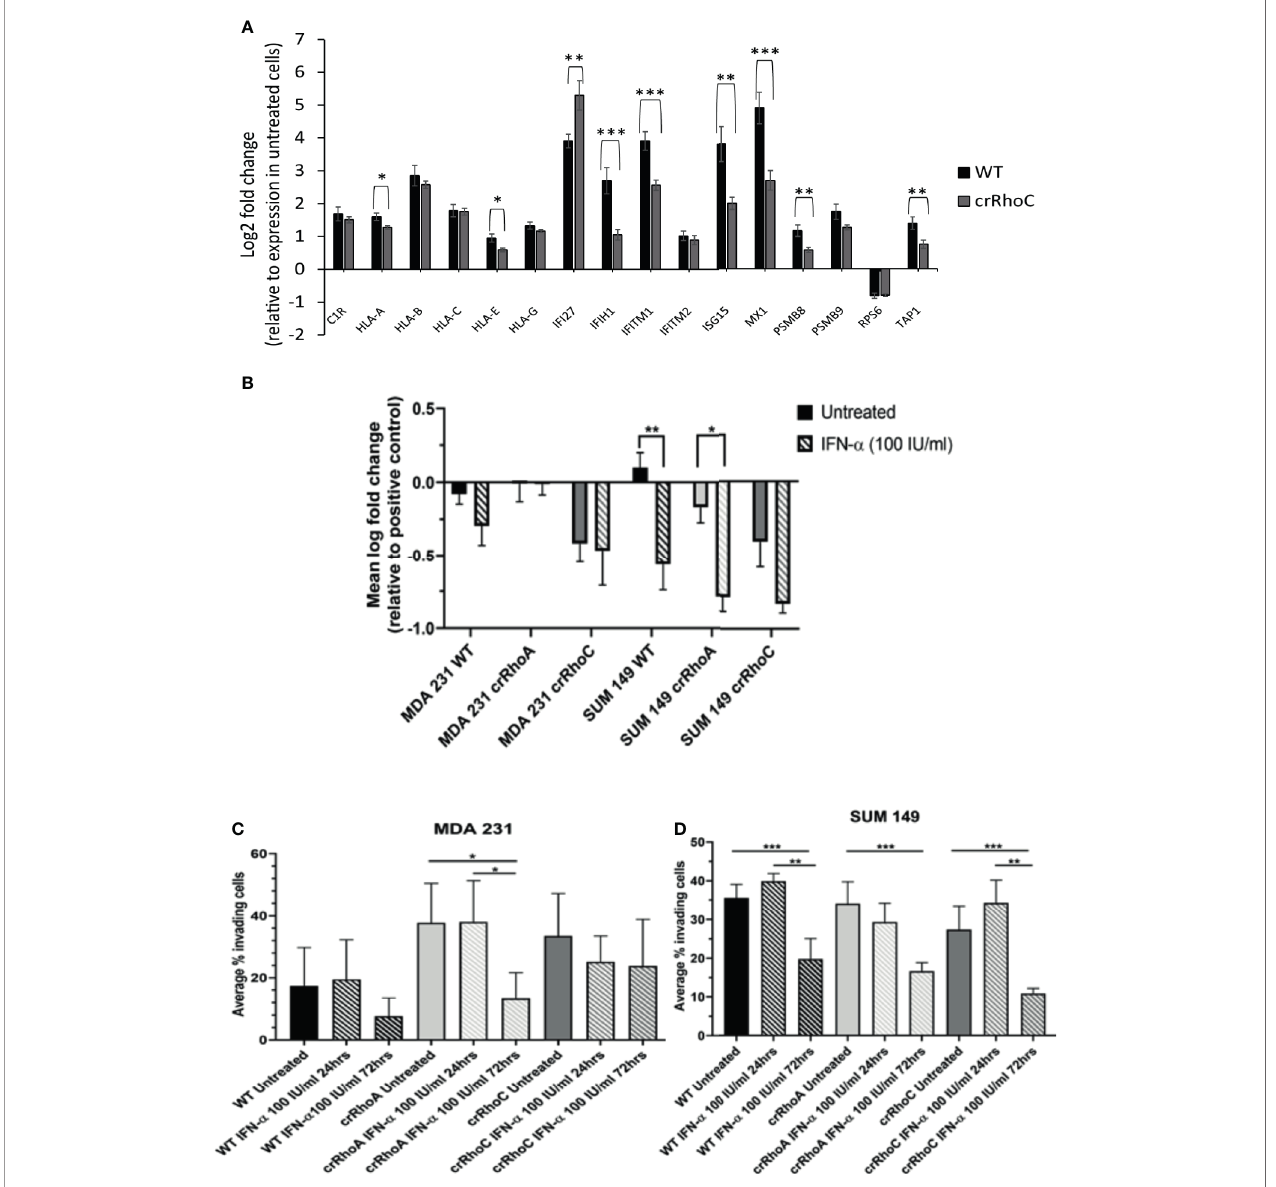
FIGURE 5 | RhoC expression modulates cells ’ functional response to interferon. (A) RNA expression of interferon stimulated genes in response to 72 hours of IFN- a treatment (100 IU/ml) in MDA 231 and SUM 149 cells. Wild-type cells had larger increases in gene expression with IFN- a treatment compared to crRhoC cells. Black bars are expression in wild-type cells, dark grey bars are expression in crRhoC cells. (B) Quanti fi cation of difference in fl uorescent intensity with IFN- a treatment between positive control (non-adhering) and test wells in centrifugation adhesion assay (n = 3 biological replicates); decreases in fl uorescent intensity correspond to increases in cell-cell adhesiveness. Treatment with IFN- a at 100 IU/ml for 72 hours led to increased adhesion for all cells, but the increases were larger and more signi fi cant in wild-type and crRhoA cells compared to crRhoC cells. (C) Quanti fi cation of transwell invasion with IFN- a treatment (n = 3 biological replicates) in MDA 231 and in (D) SUM 149. Treatment with IFN- a led to decreased invasion for all cells; in MDA 231 wild-type and crRhoA cells had larger and more signi fi cant decreases than in crRhoC cells, whereas in SUM 149 crRhoC cells had the largest relative decrease in invasion. Downward-slanting stripes represent IFN- a treatment; black bars are wild-type, light grey bars are crRhoA cells, and dark grey bars are crRhoC cells. *p < 0.05; **p < 0.01; ***p <